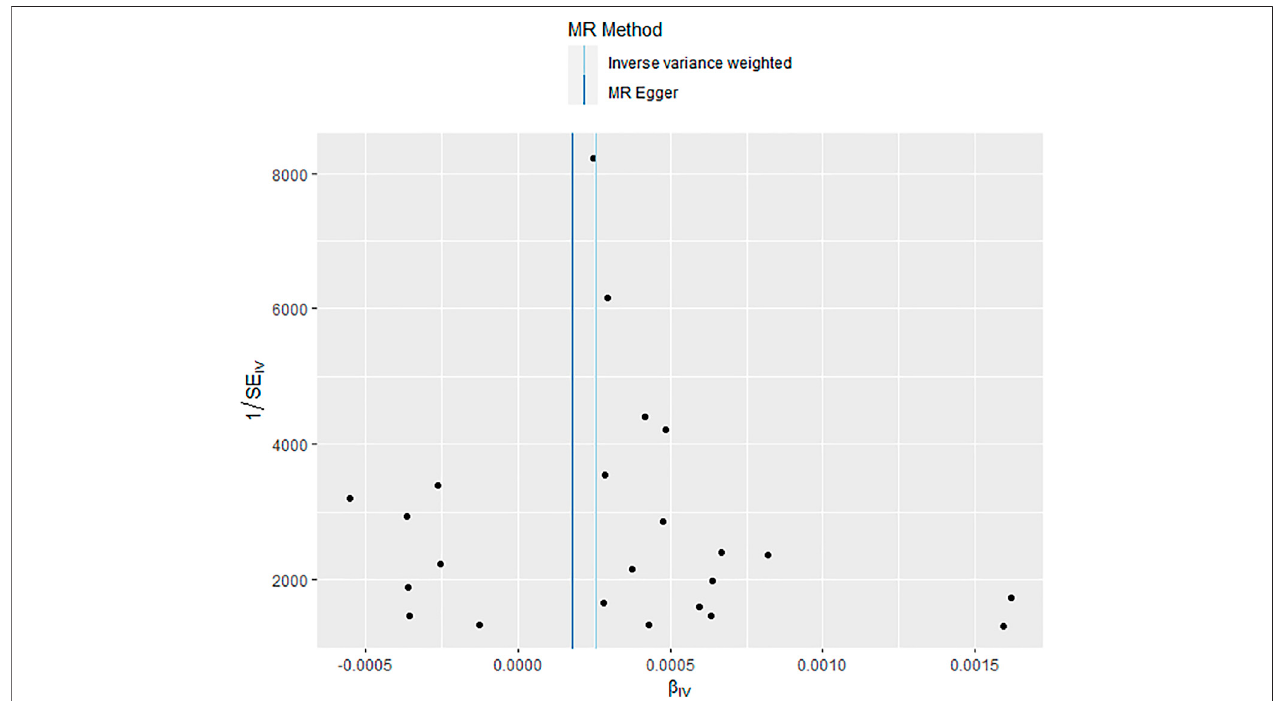
FIGURE 3 | Funnel plot showed no signi fi cant heterogeneity among single nucleotide polymorphisms (SNPs).